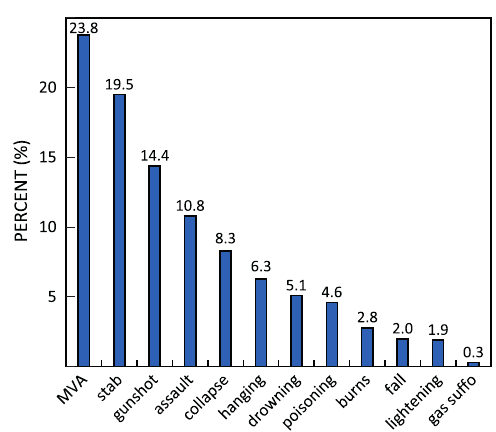
Figure 3: Percentages of causes of death in the Transkei region of South Africa from 1996 to 2015 ( n = 24 693).